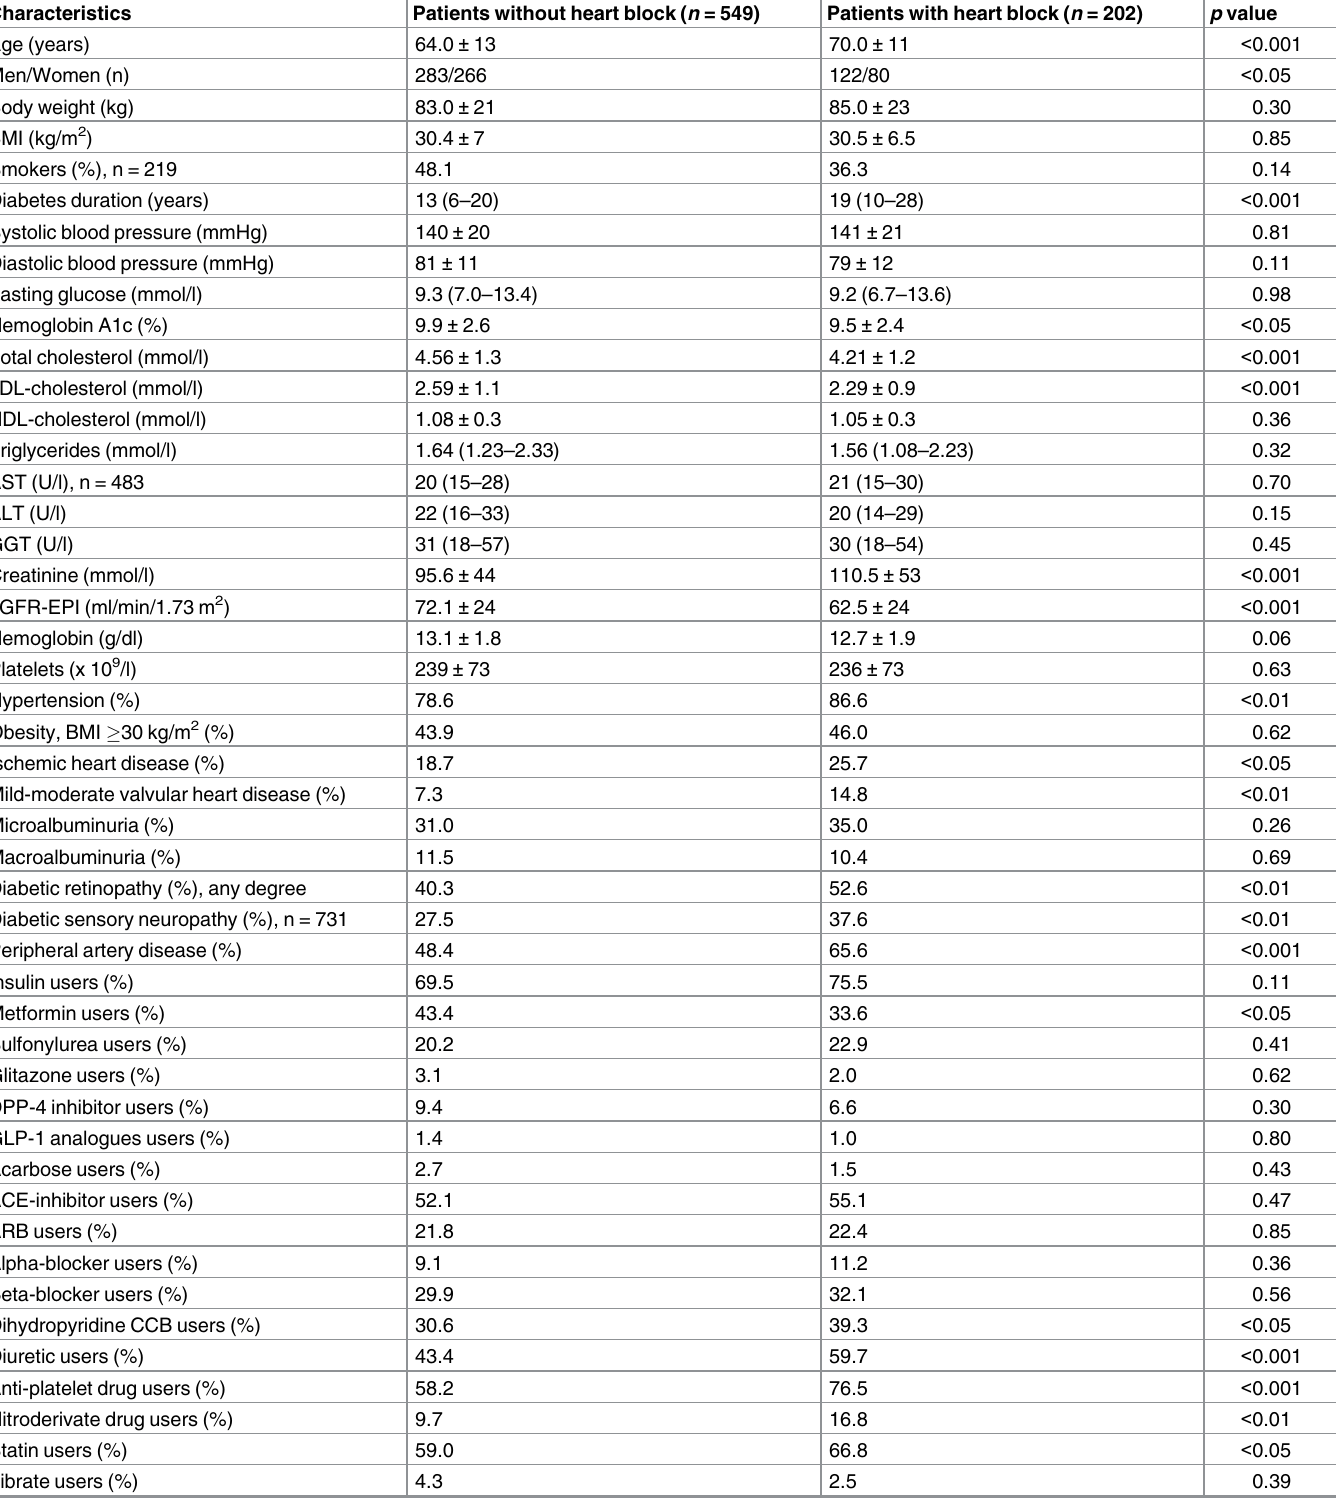
Table 1. Clinical, biochemical and electrocardiographic characteristics of patients with T2DM stratified by heart block